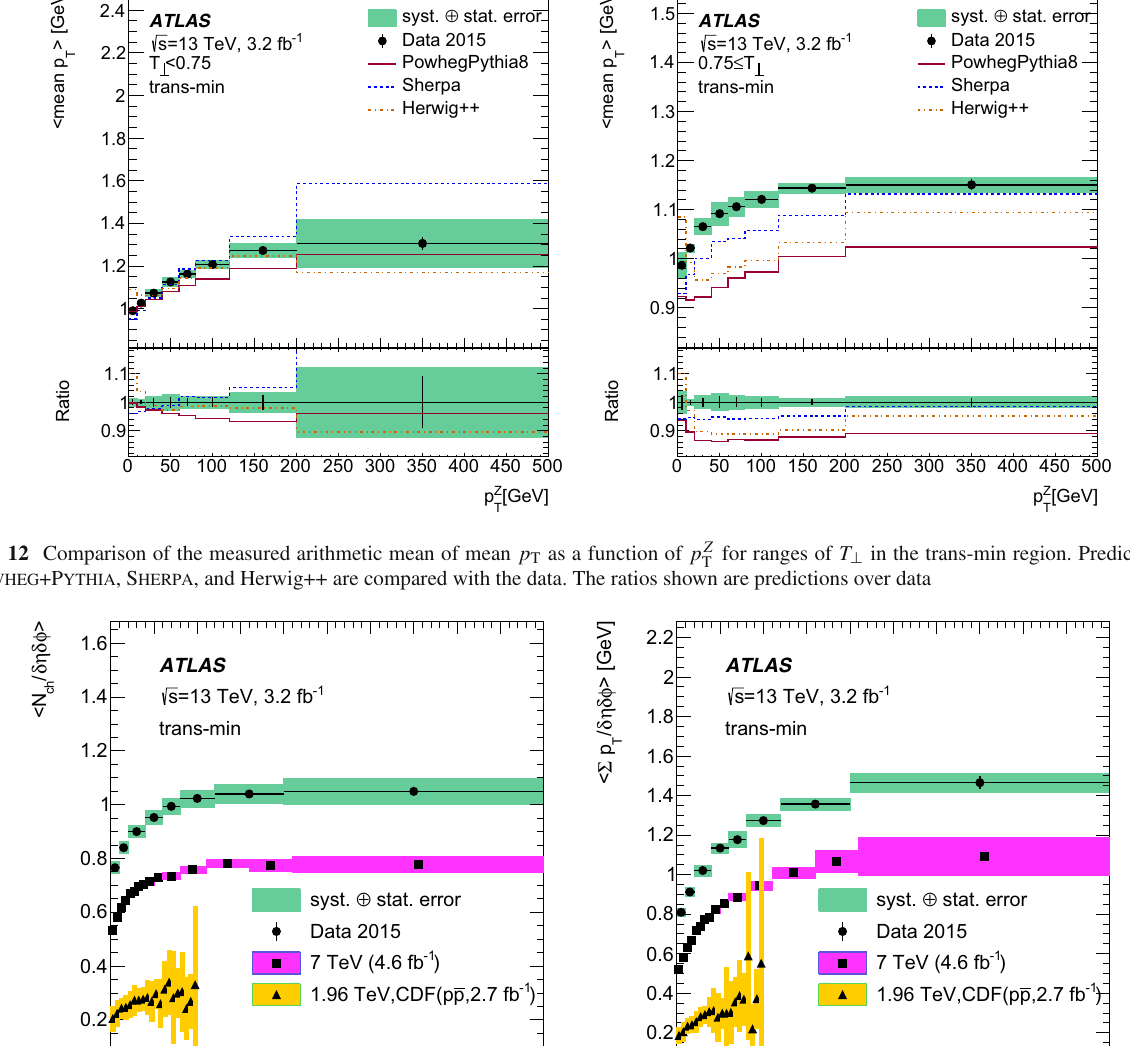
UE e.g. MPI. Hence, the rise of the UE activity as a function √ s is of